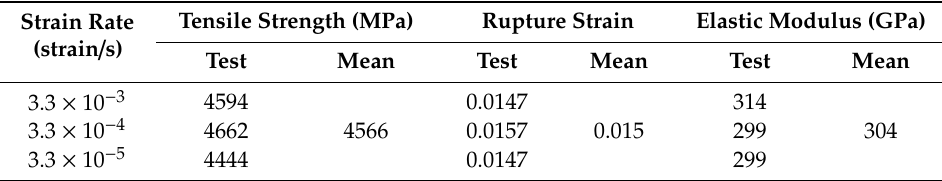
Table 2. Material properties of carbon fiber-reinforced polymer (CFRP).